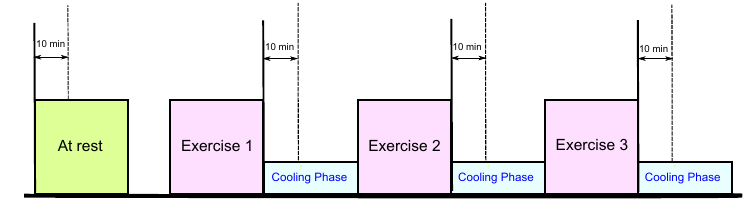
Figure 1. Measurement protocol. The duration of the whole experiment was approximately 4 h; each exercise consumed approximately 30 min, while the photoplethysmogram (PPG) signals were collected during the 30-minute break of each